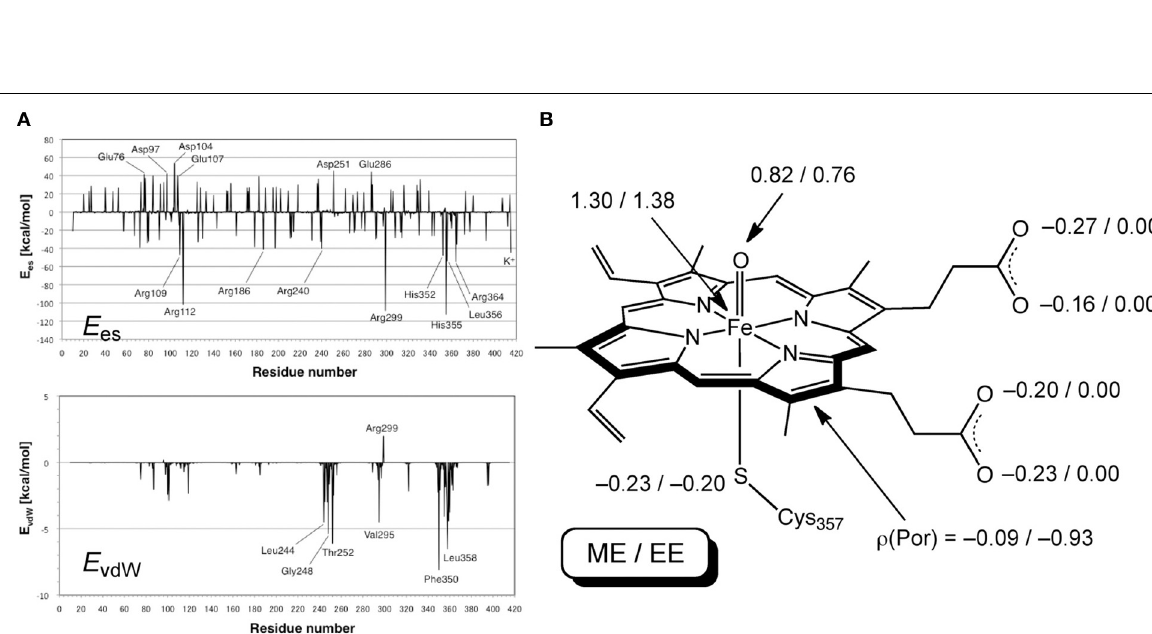
FIGURE 10 | (A) E es and E vdW of each residue. (B) Key atomic spin populations calculated by ONIOM-ME and ONIOM-EE calculations. Adapted from Hirao (2011a) with permission from the Chemical Society of Japan.